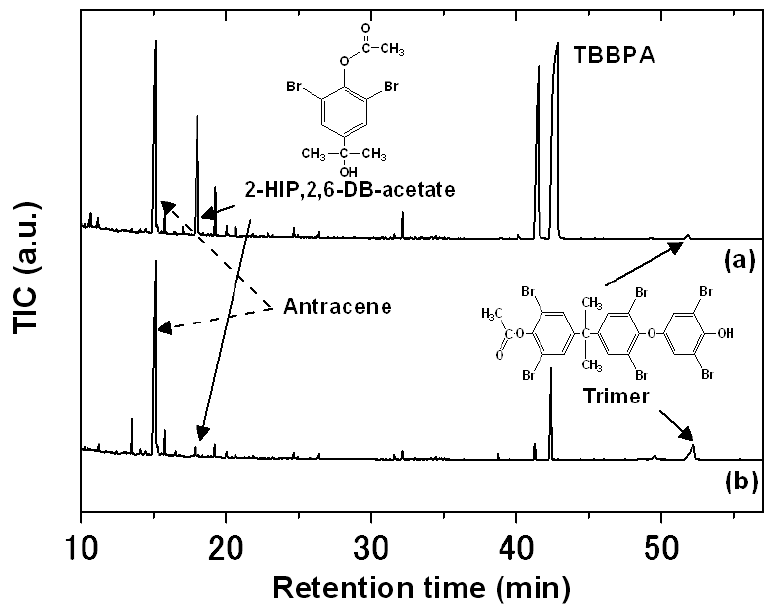
Figure 4. GC/MS chromatograms of n -hexane extract from the reaction mixture at pH 8 in the presence of HA. Reaction period ( a ) 1.5 h, ( b ) 5 h. Reaction conditions: [TBBPA] , 50  M; [FeTPPS/IPS], 10  M (0.3 g L −1 ); [KHSO 0